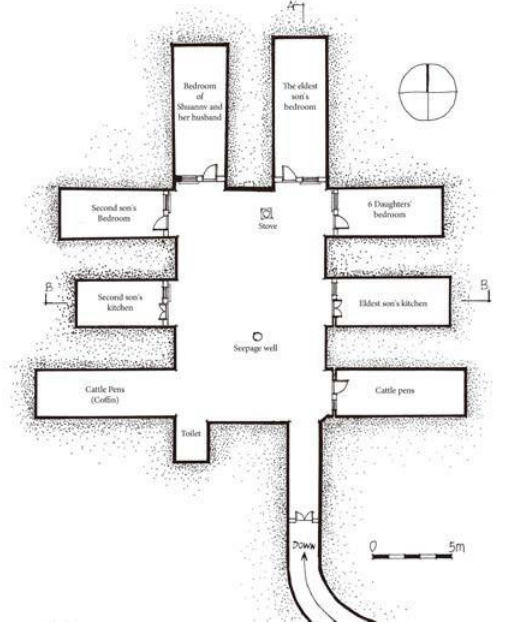
Figure 13. Cave distribution in No.2